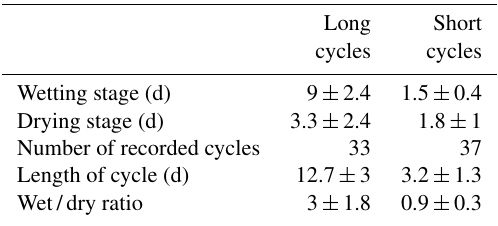
Table 1. Technical information of the recorded long and short wet- ting and drying cycles (these data were provided by the Shafdan